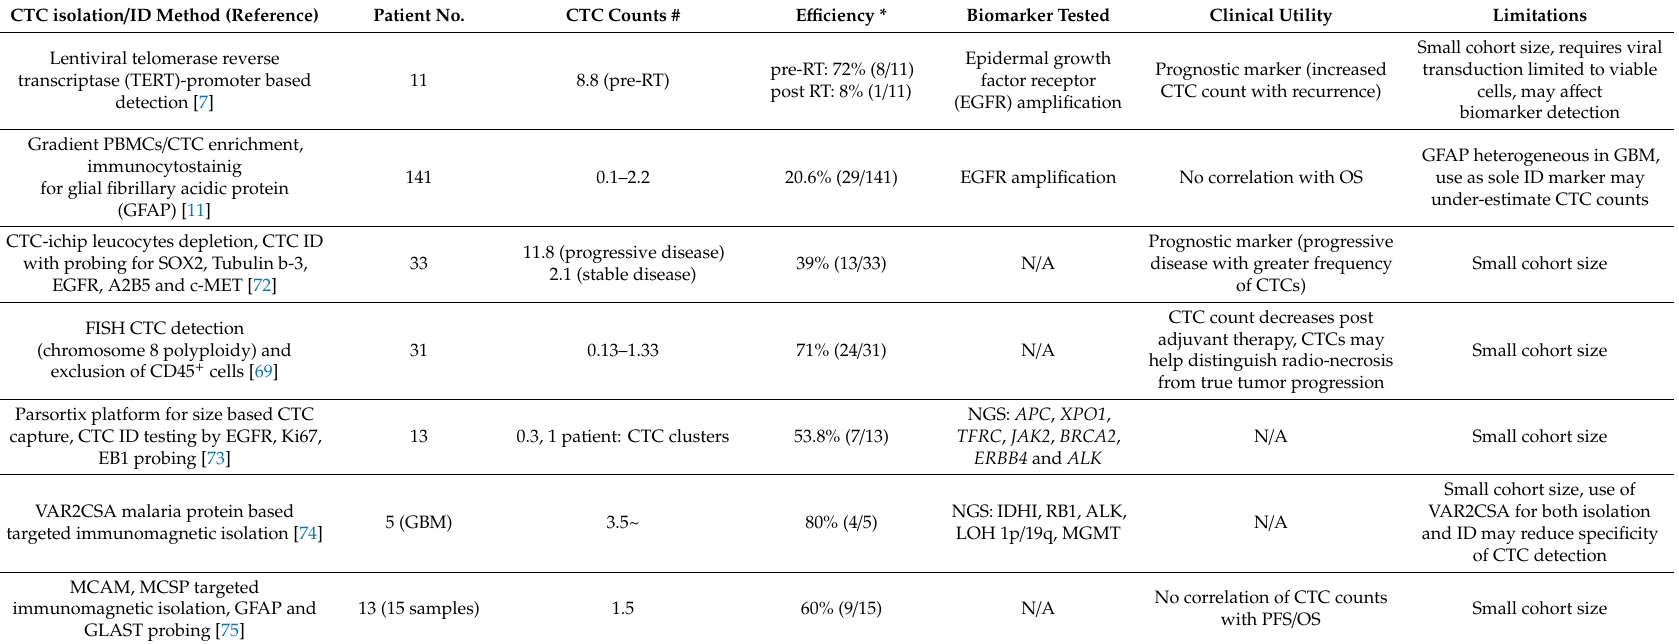
Table 2. CTC detection in glioblastoma multiforme (GBM) patient